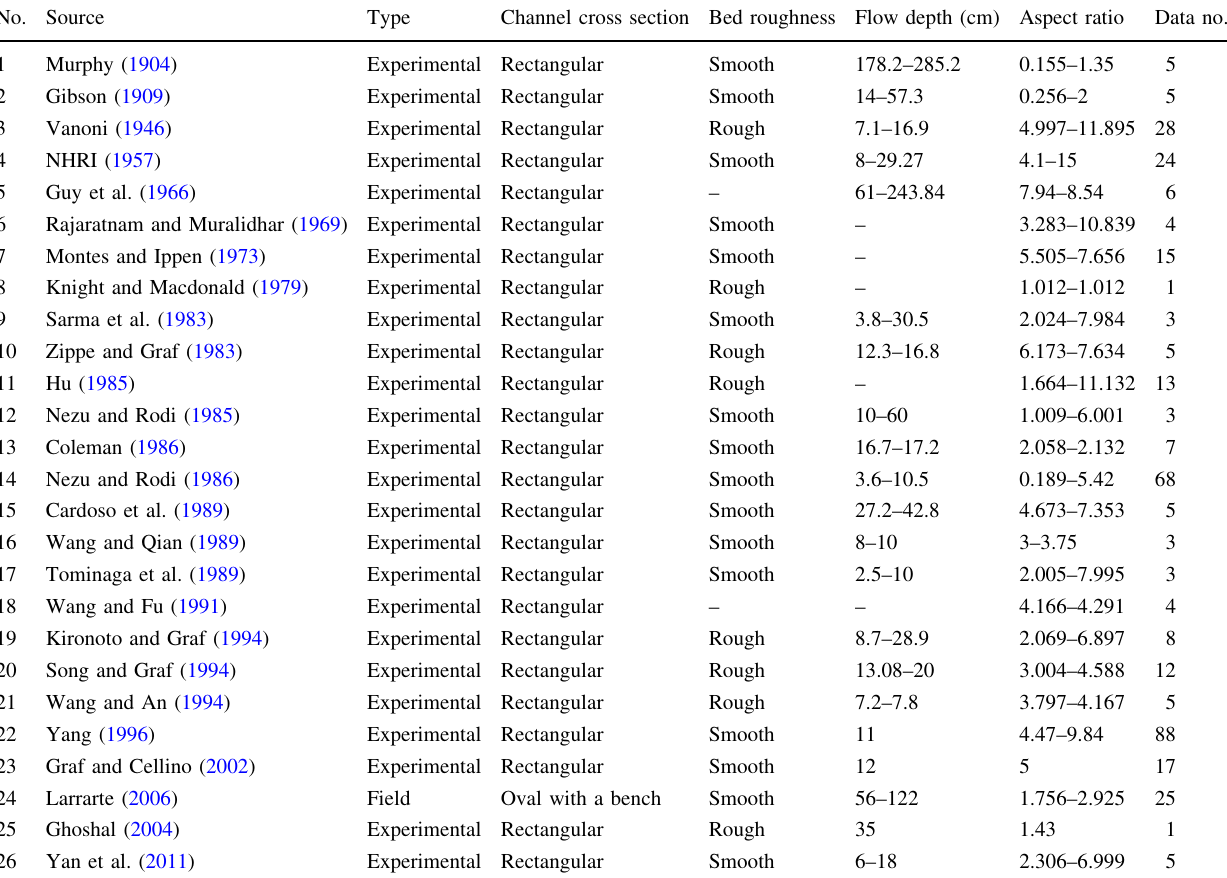
Table 1 Details of selected datasets in steady and uniform flow No.